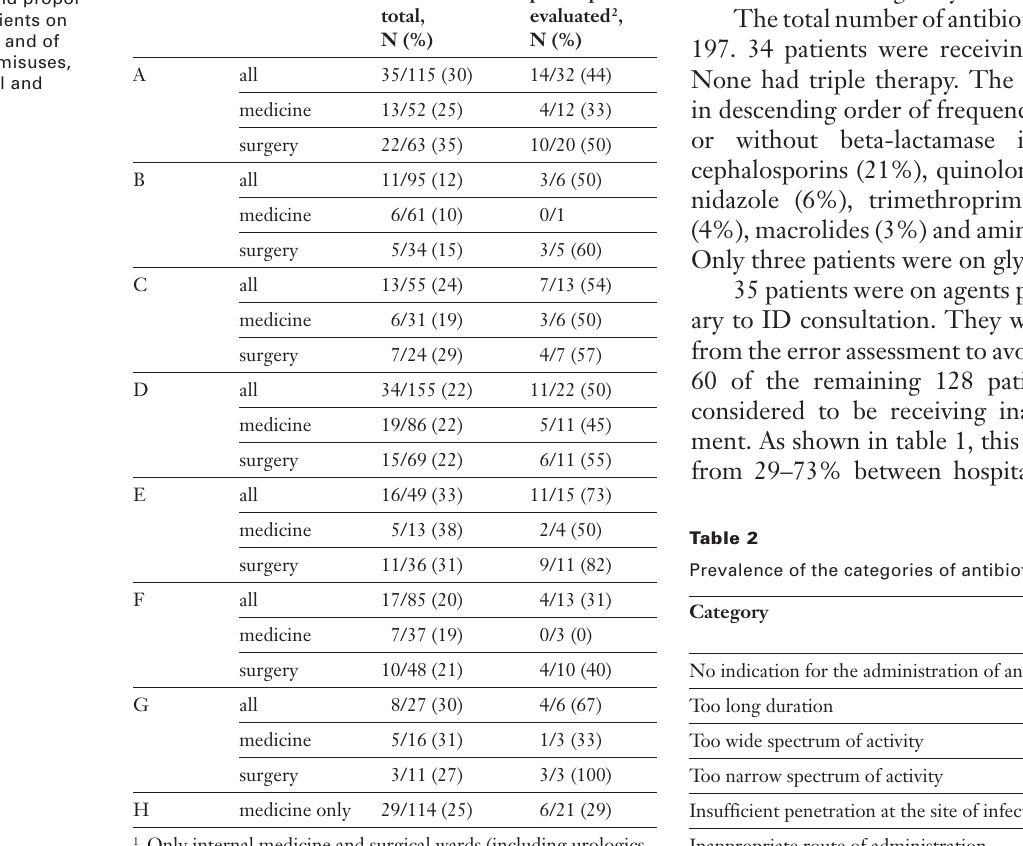
Number and propor- tion of patients on antibiotics and of antibiotic misuses, by hospital and by ward.